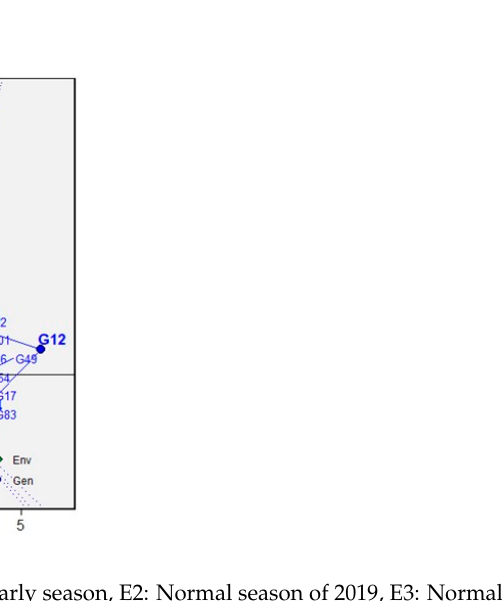
Figure 3. GxE analysis result of FG (E1: Early season, E2: Normal season of 2019, E3: Normal season of 2021, E4: Late season of 2018). The result indicates qFG3 is detected under certain Environment.